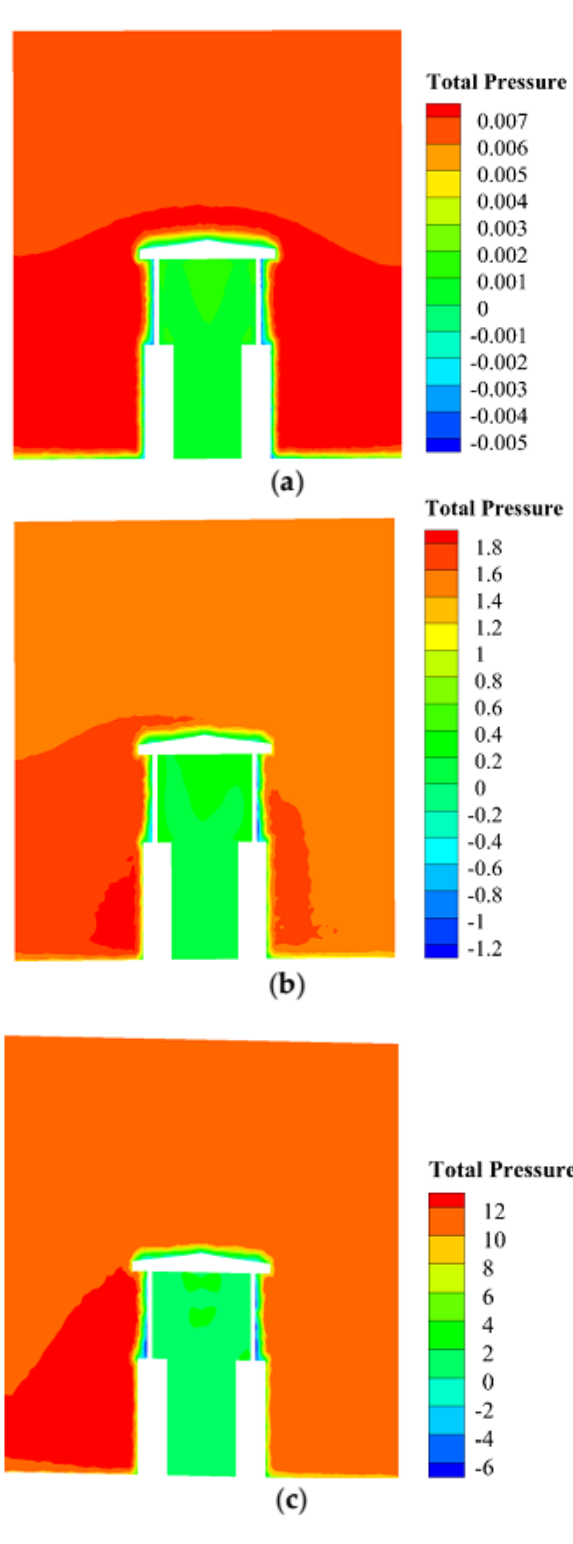
Figure 16. Distribution of total pressure in yz-plane for different inlet wind velocities: ( a ) 0.1 m/s; ( b ) 1.5 m/s; and ( c ) 4 m/s. In this figure, the unit of total pressure is